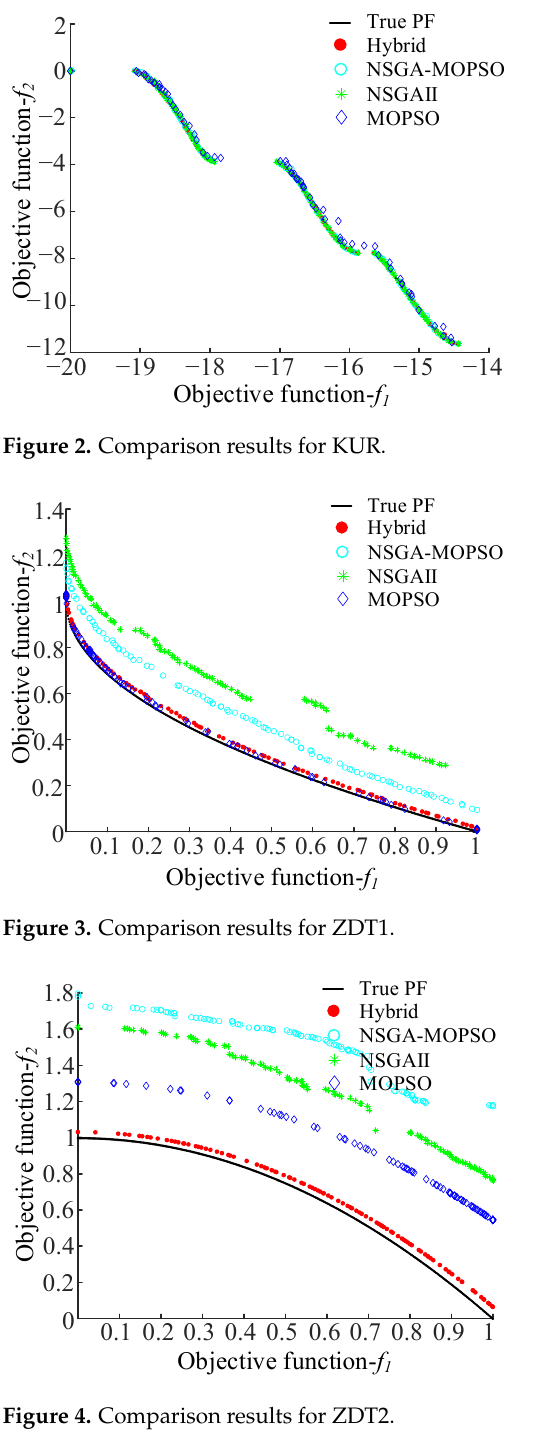
Figure 5. Comparison results for ZDT3. Figure 6. Comparison results for ZDT4. Figure 7. Comparison results for ZDT6.